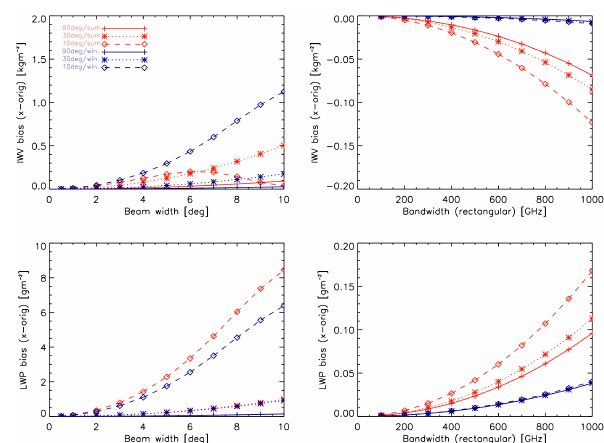
Fig. 18. The error in the retrieved IWV (in kgm − 2 ) and LWP (in gm − 2 ) zenith corrected caused by the errors in TB by not taking Figure 18. The error in the retrieved IWV (in kg/m 2 ) and LWP (in g/m 2 ) zenith corrected 5 into account antenna beam width (right) or bandwidth (left). The caused by the errors in TB by not taking into account antenna beam width (right) or 6 errors are shown for both the mid-latitude summer (red) and the bandwidth (left). The errors are shown for both the mid-latitude summer (red) and the mid-7 mid-latitude winter cloudy soundings (blue) for elevation angles latitude winter cloudy soundings (blue) for elevation angles 10° (dash square), 30° ( dot star), 8 10 ◦ (dash square), 30 ◦ (dot star) and 90 ◦ (line + ) . and 90° (line +). 9 the bandwidth are omitted in the calculations. The